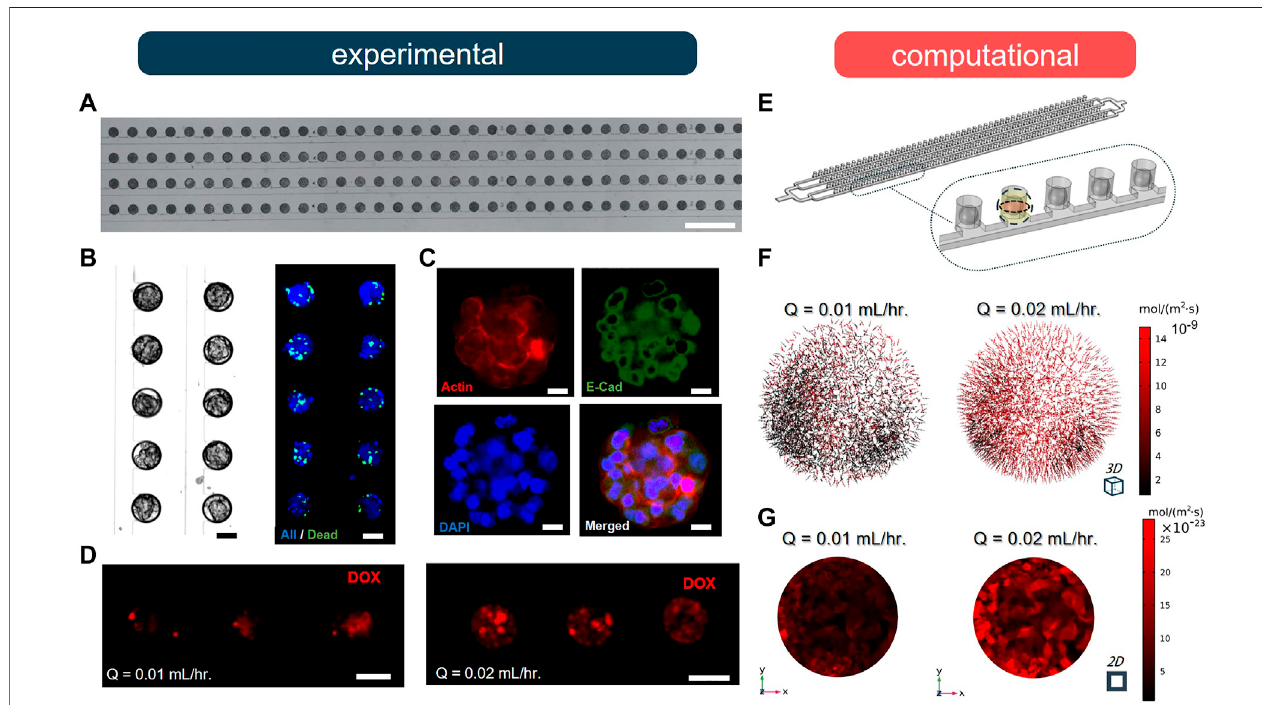
FIGURE 4 | Doxorubicin (DOX) uptake by spheroid under two different fl ow rates ( n (cid:2) 5). (A) A fragment of the 100 μ m-diameter arrays of MCF-7 breast cancer spheroids after loading. Scale bar is 1 mm. (B) Bright fi eld and fl uorescence (NucGreen ® /NucBlue) images of formed MCF-7 breast cancer spheroids after 72 h cell culture. Scale bar is 50 µm. (C) Immuno fl uorescence staining of tumour spheroids after 72 h of cell culture by E-cadherin antibody (green),DAPI (blue) and F-actin (red). Scale bar is 25 µm. (D) Fluorescence images of spheroids after 2 h perfusion of 10 µM DOX under different fl ow conditions. Scale bar is 100 µm. (E) The de fi ned geometry and porous medium domain in COMSOL Multiphysics. (F) Results of drug penetration within the spheroid are visualized as arrows based on the total fl ux of molecules. (G) Results of total fl ux of DOX evaluated in the midplane of spheroid when Q (cid:2) 0.01 ml/h and 0.02 ml/h.